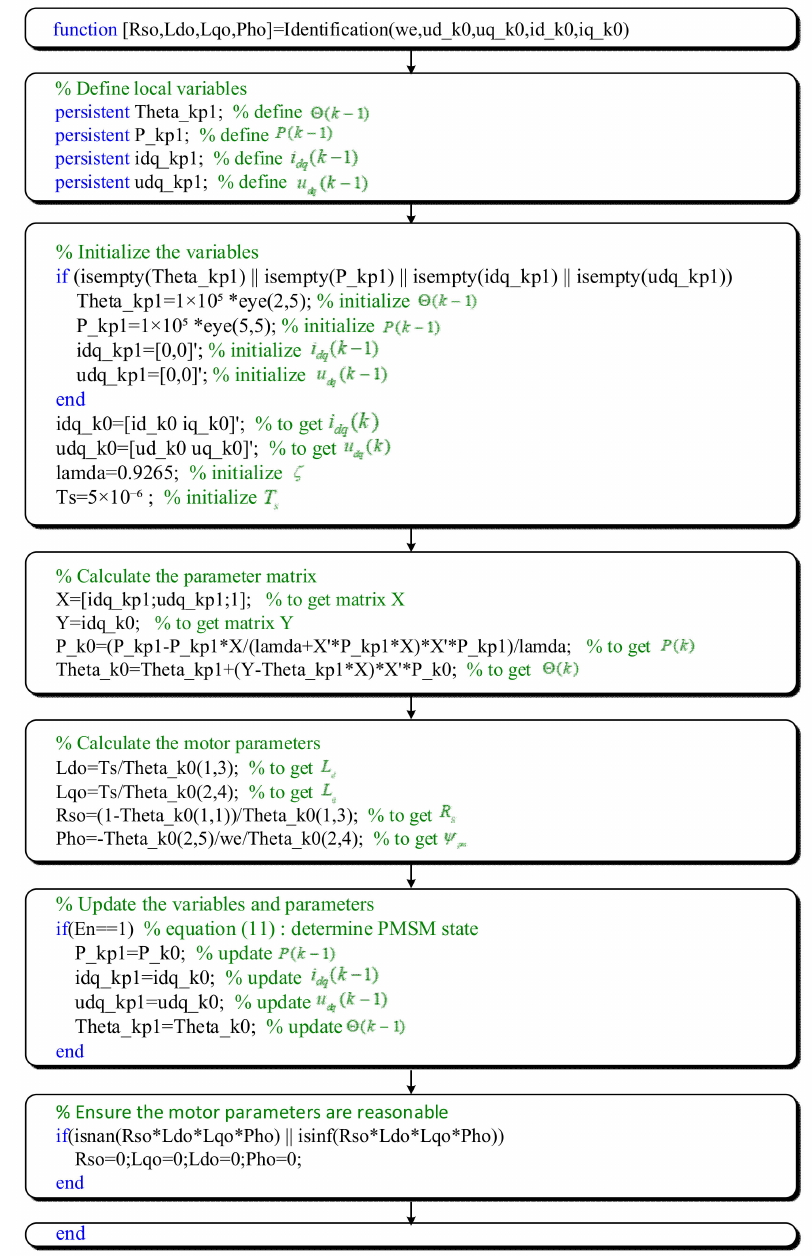
Figure 5. The function to realize RLS parameter